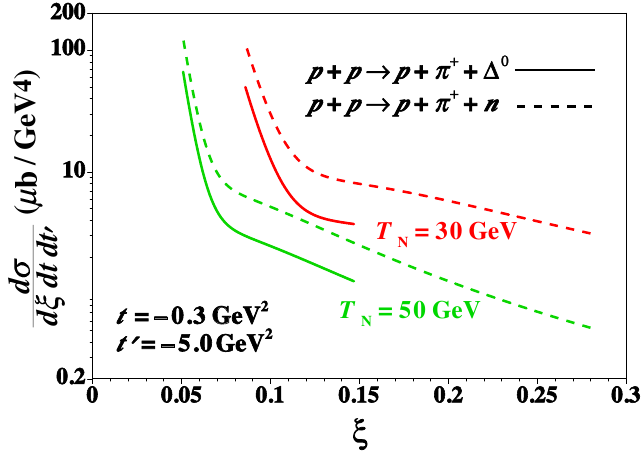
Figure 11. Typical 2 → 3 process pp → p π B and GPD in the ERBL region. See text for details.